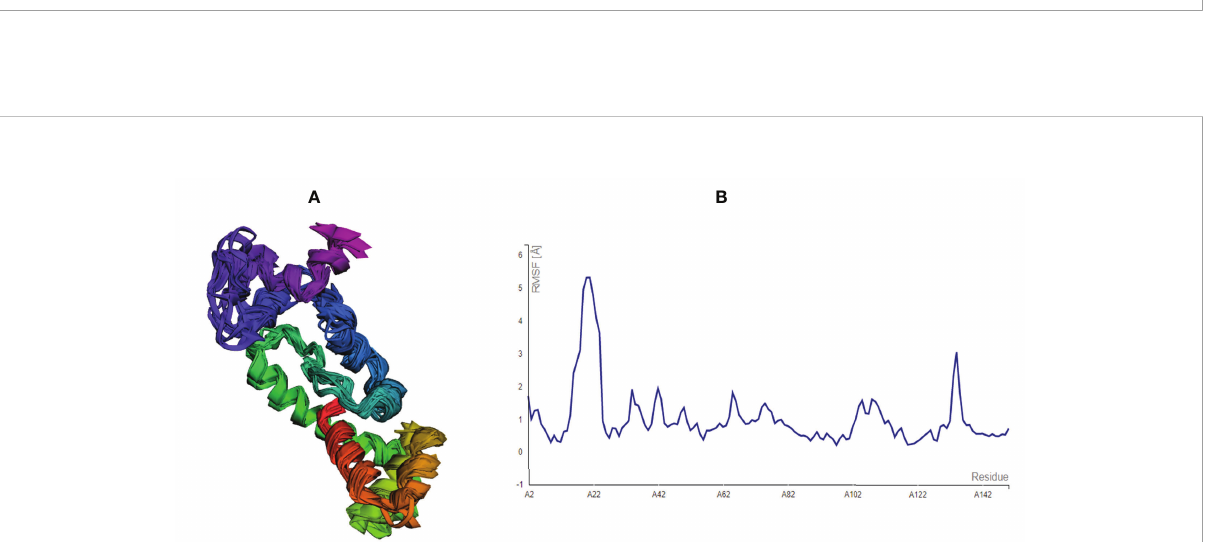
FIGURE 4 Structural fl exibility assessment of the improved MEMPV: (A) 10 superposed MEMPV models (B) Root mean square fl uctuation (RMSF) fi ndings of the proposed MEMPV